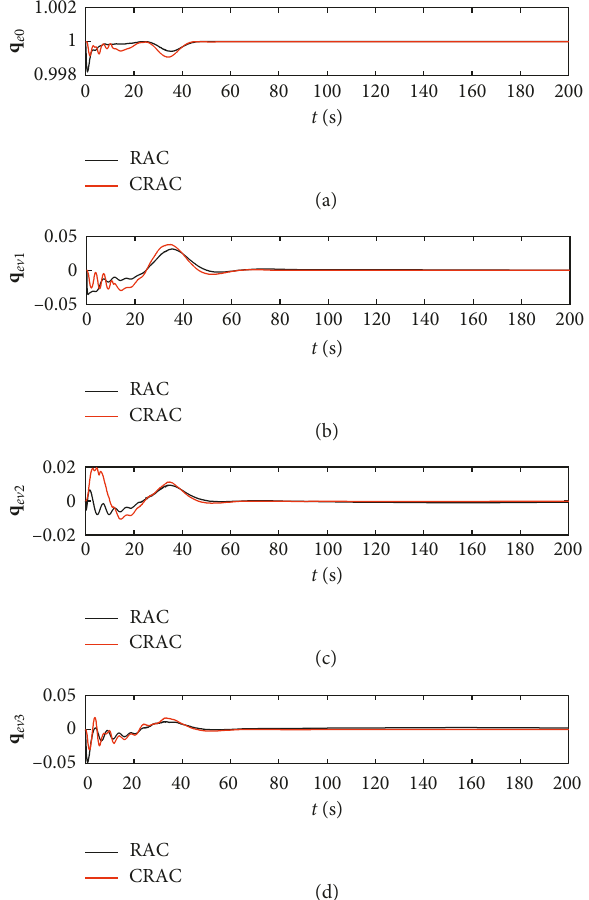
Figure 7: Time response of attitude tracking error in quaternion.